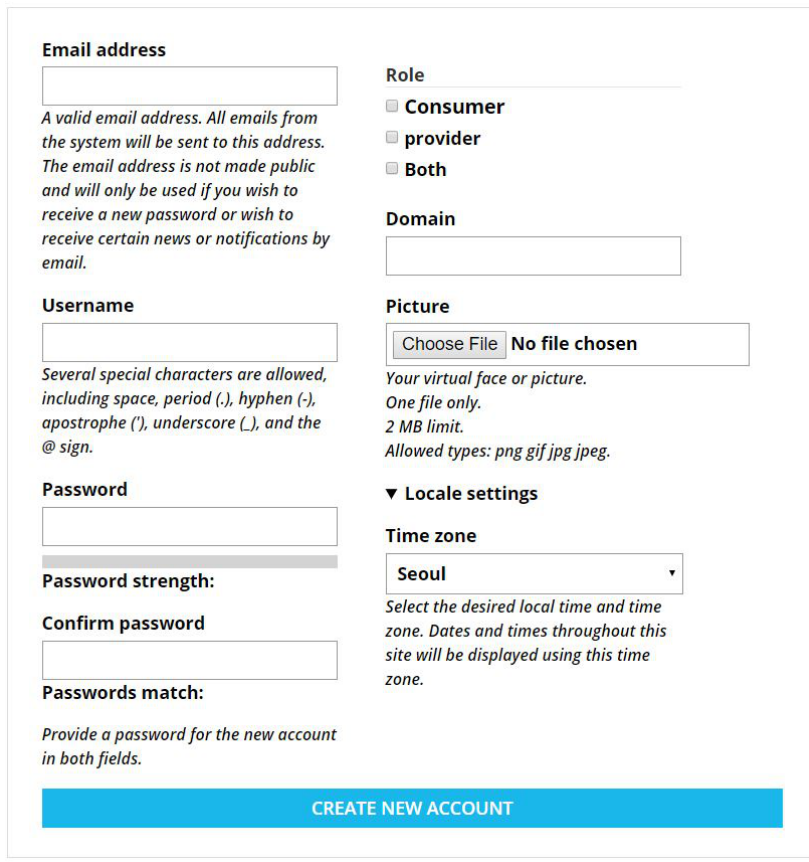
Figure 4. User registration